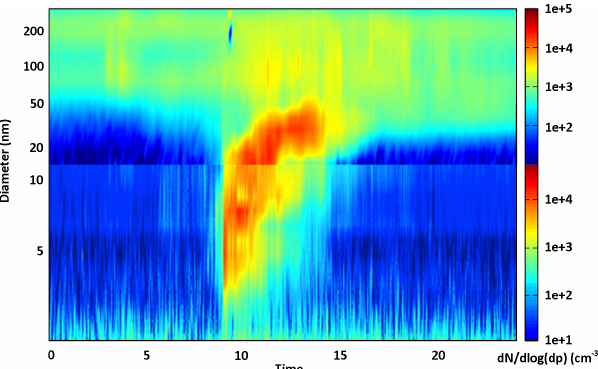
Figure 8. Example of size distribution spectra, measured with DMPS and NAIS, showing an NPF event of type Ia occurring on 14 March 2015 at the CAO